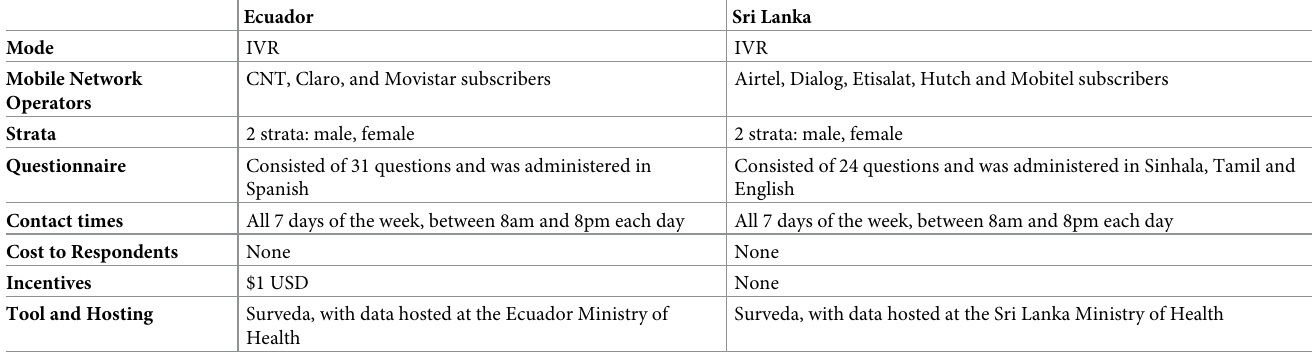
Table 1. COVID-19 mobile phone survey design in Ecuador and Sri